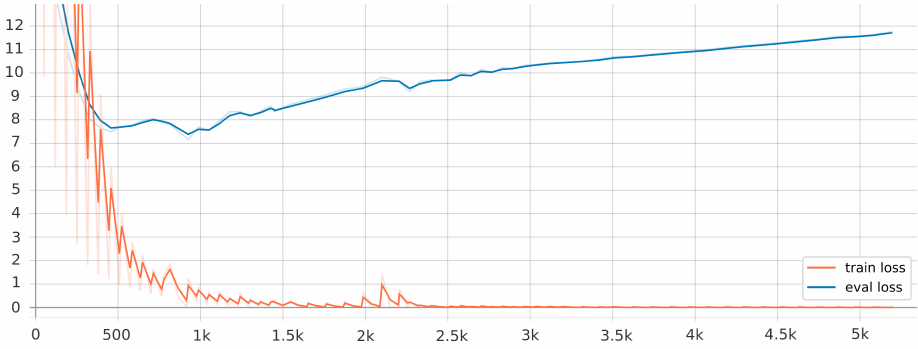
Figure 13. BI-LSTM-CRF model learning